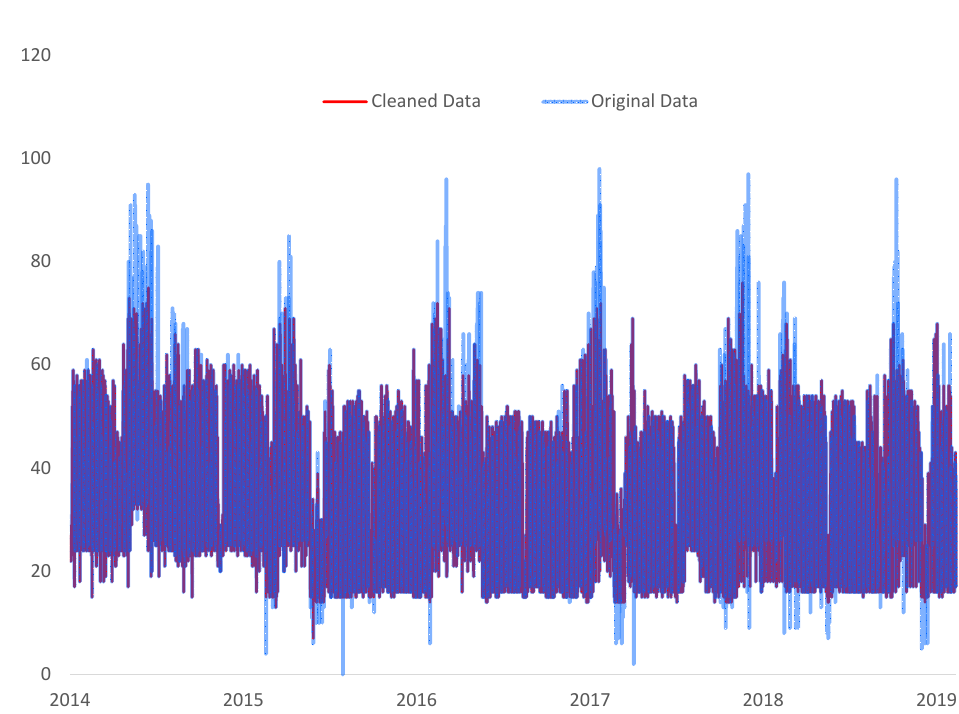
Figure 5. Original and cleaned data for swimming pool complex location.